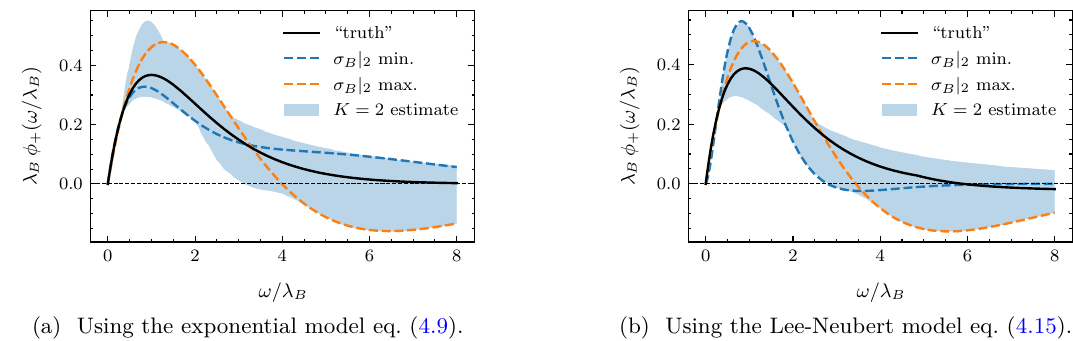
Figure 6 . Pseudo-fit to the B -meson LCDA in momentum space using the two pseudo-observables p 1 , 2 as predicted by two models as a function of x = ω/λ B . We show the model (“truth”), the curves that lead to extreme values of σ latter, we take the benchmark interval for ξ = ω